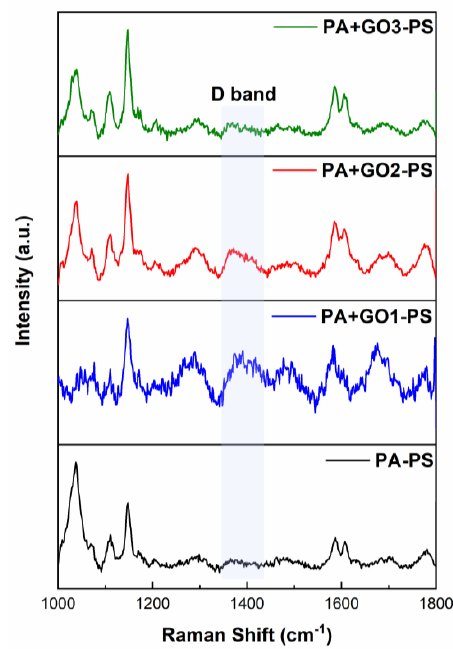
Figure 5. Raman spectra of membranes. Polymers 2020 , 12 , x FOR PEER REVIEW